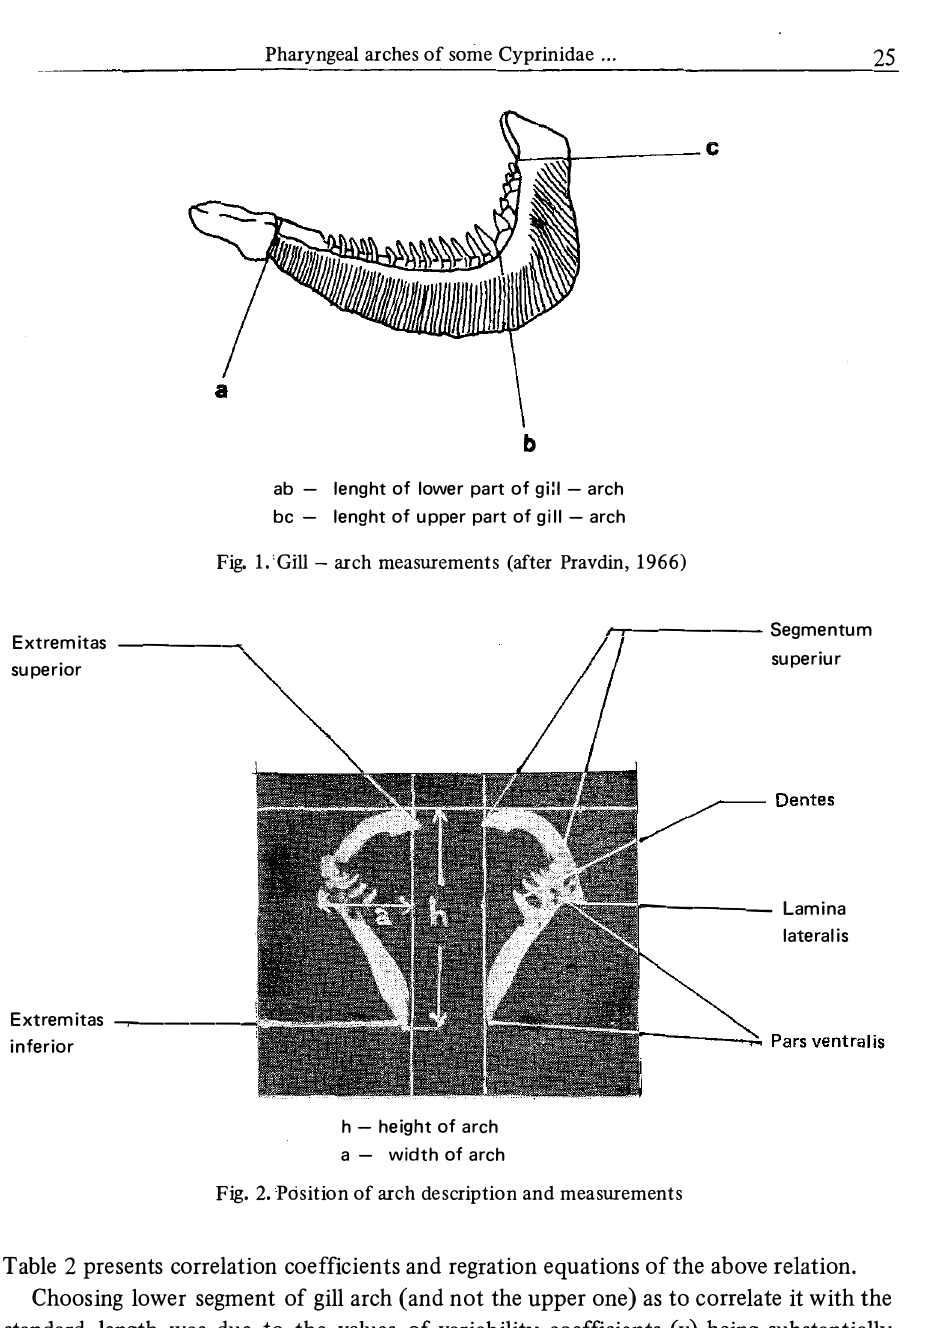
Table 2 presents correlation coefficients and regration equations of the above